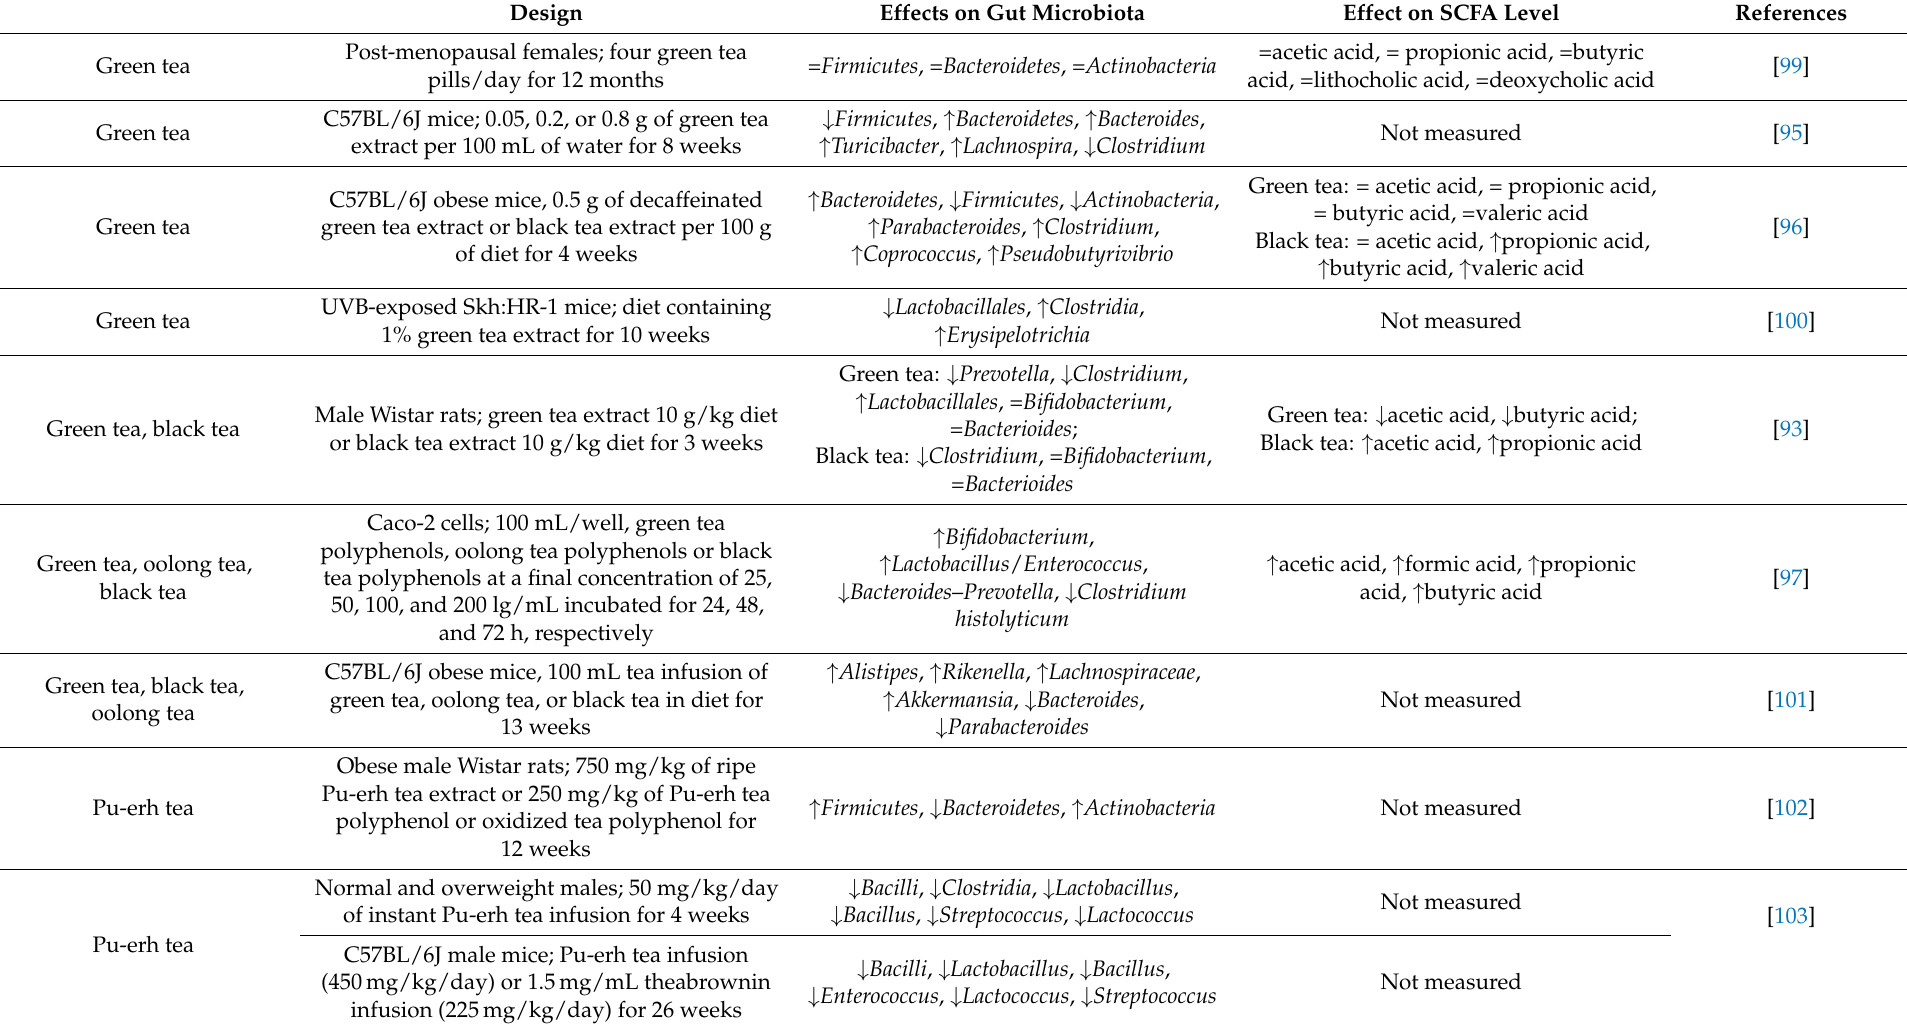
Table 1. Influence of tea on the microbiota